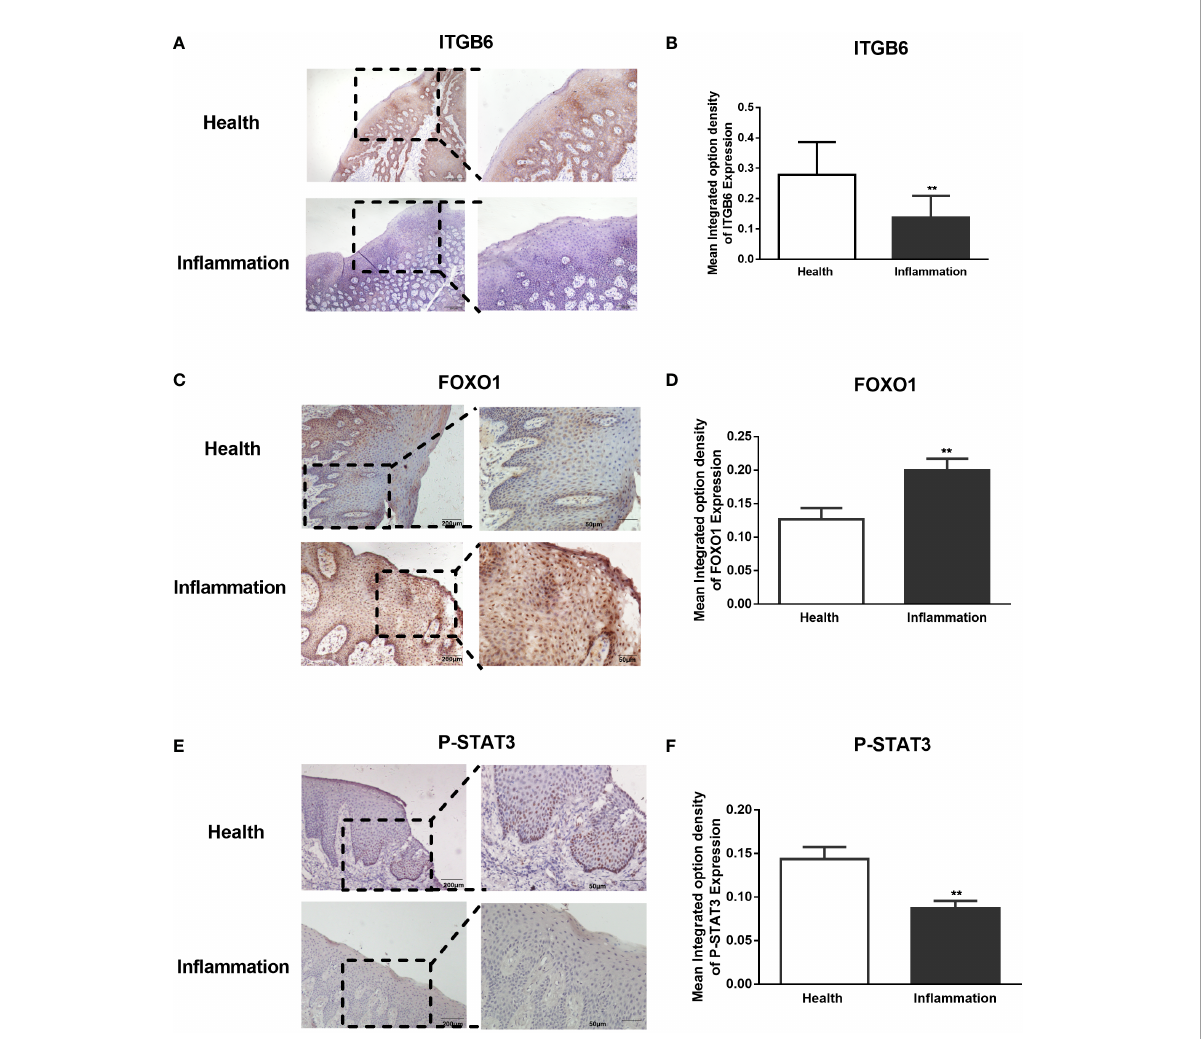
FIGURE 6 Expression of ITGB6, FoxO1, and phosphorated STAT3 in human gingival epithelium. Paraf fi n-embedded human gingival epithelia were obtained from patients who had undergone tooth extraction for periodontitis treatment (n = 5) or orthodontic treatment as healthy controls (n=5). Immunohistochemistry for ITGB6, phosphorated STAT3, and FOXO1 was performed. Representative sections of healthy gingival epithelium showing strong staining of ITGB6 in the cytosol (A) and phosphorylated STAT3 in the nucleus (E) , whereas both molecules were barely expressed in periodontal disease specimens. In contrast, a representative section of in fl ammatory gingival epithelium showed strong staining of FOXO1 in both the nucleus and cytoplasm, whereas minor staining was detected in healthy gingival epithelium (C) . (A) Low power scale